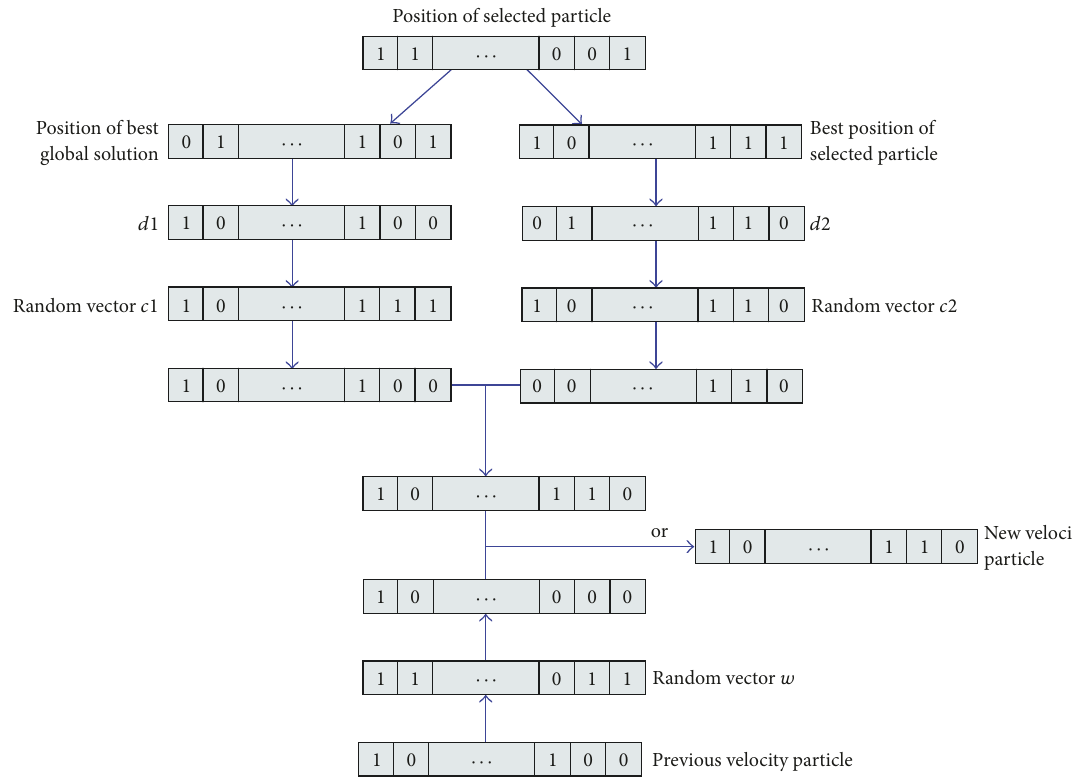
Figure 5: Example of Boolean